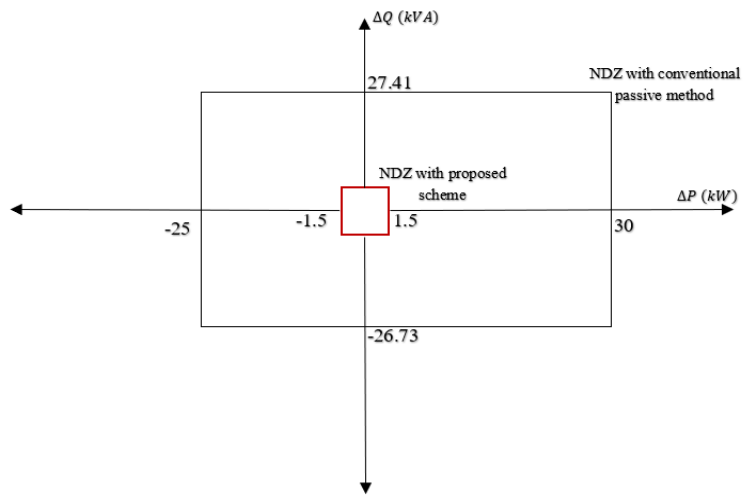
Figure 2 . NDZ operating area for conventional and proposed islanding detection technique. Figure 2. NDZ operating area for conventional and proposed islanding detection